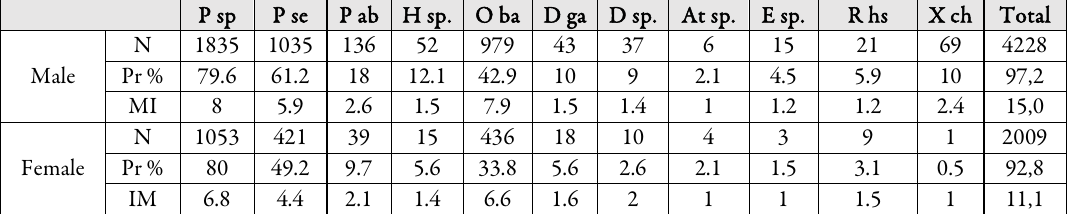
Table 3. Prevalence (Pr %) and mean intensity (MI) of R. rattus ectoparasites depending on